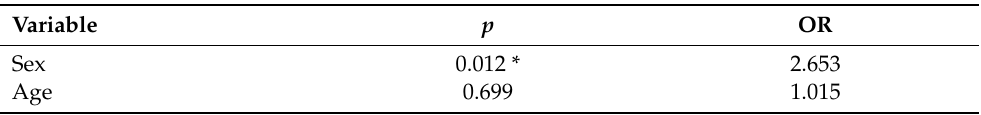
Table 7. Results of the logistic regression model with the maturational stages of the midpalatal suture as outcome variable and age and sex as